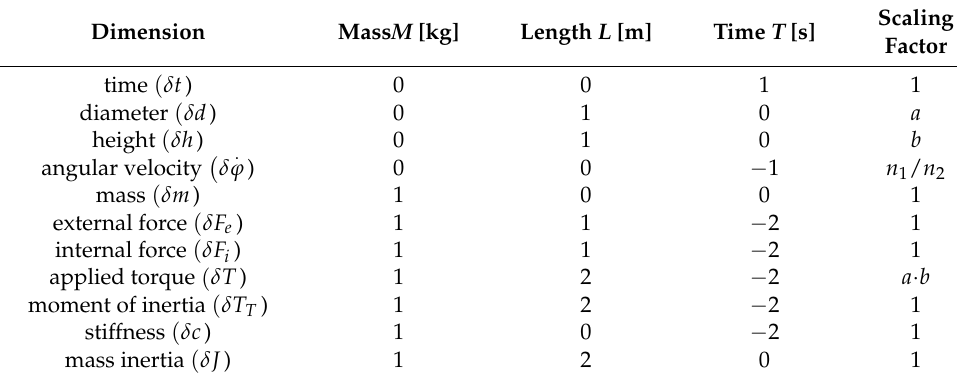
Table 2. Summary of the scaling factors.